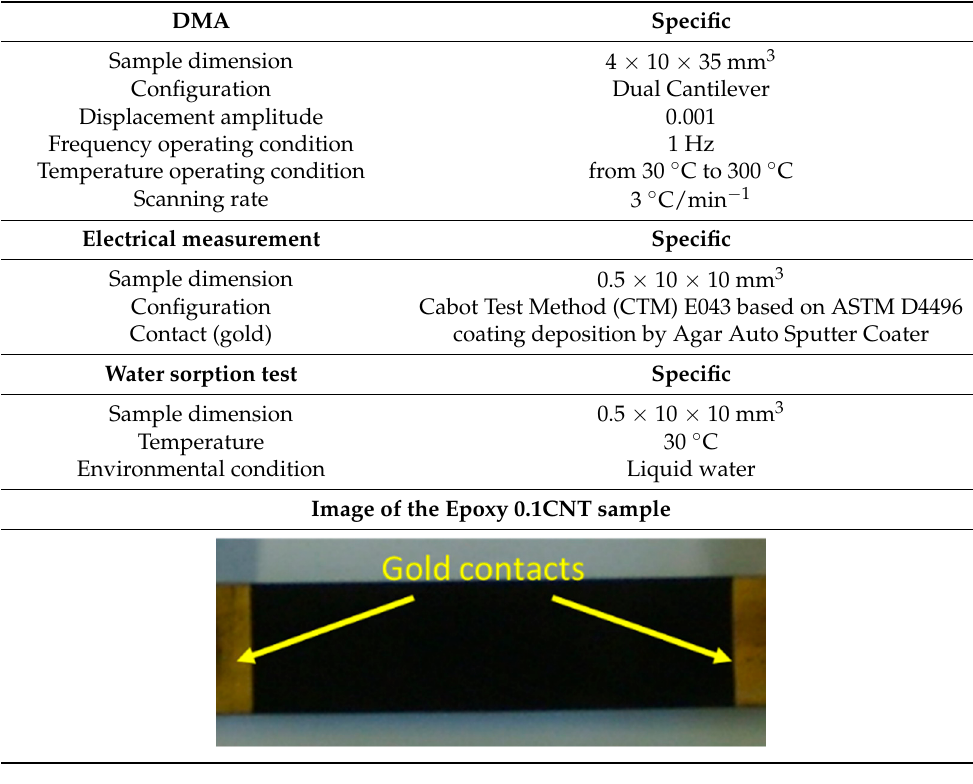
Table 2. Characterization methods.